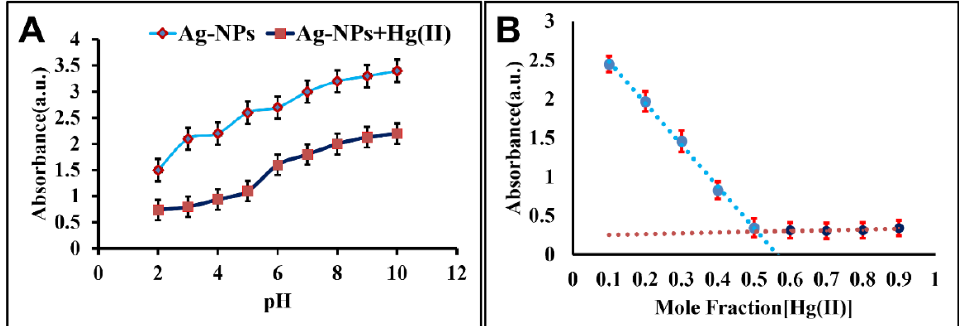
Figure 5. ( A ) Effect of pH on the adsorption of AgNPs in the absence and presence of 100 ppm Hg 2+ ions, ( B ) Job’s plot curve showing the binding ratio of AgNPs:Hg 2+ .